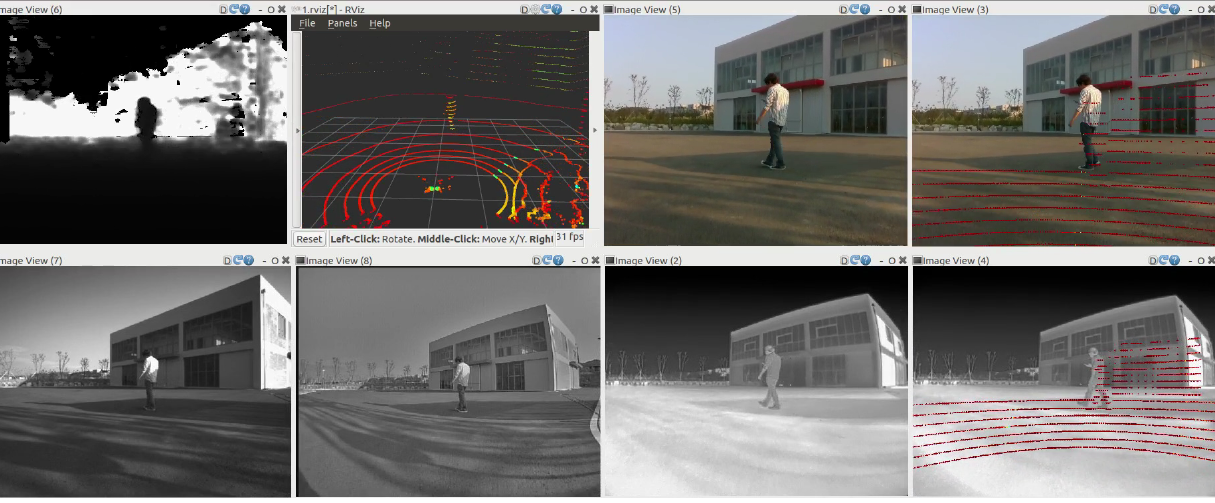
Figure 16. Example of the calibrated data.